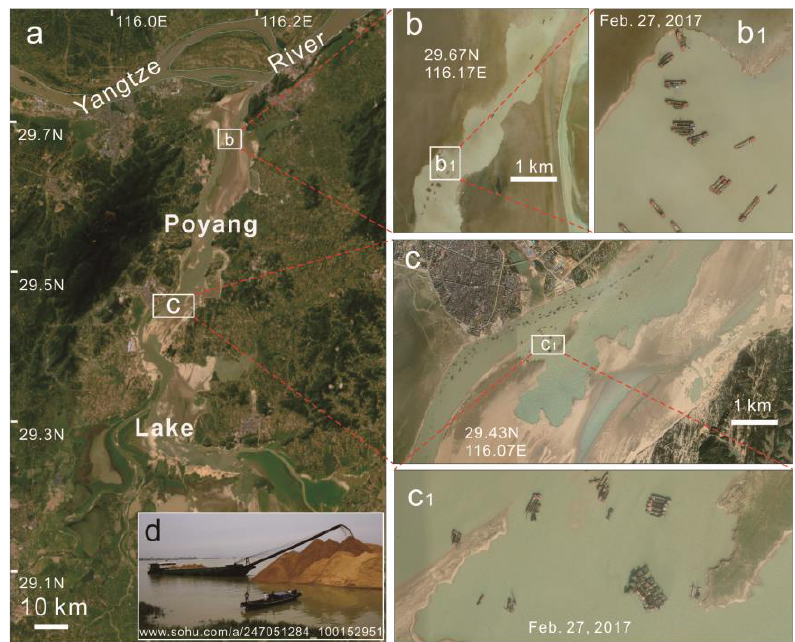
Figure 4. Maps show the location of Poyang Lake. ( a ) Poyang Lake from remote sensing image. ( b ) and ( c ) Sawtooth sandbar in the Poyang Lake formed by sand mining in 2017. ( b 1 ) and ( c 1 ) Sand mining equipment in operation on 27 February 2017. ( d ) Photo of a sand dredger in Poyang Lake.